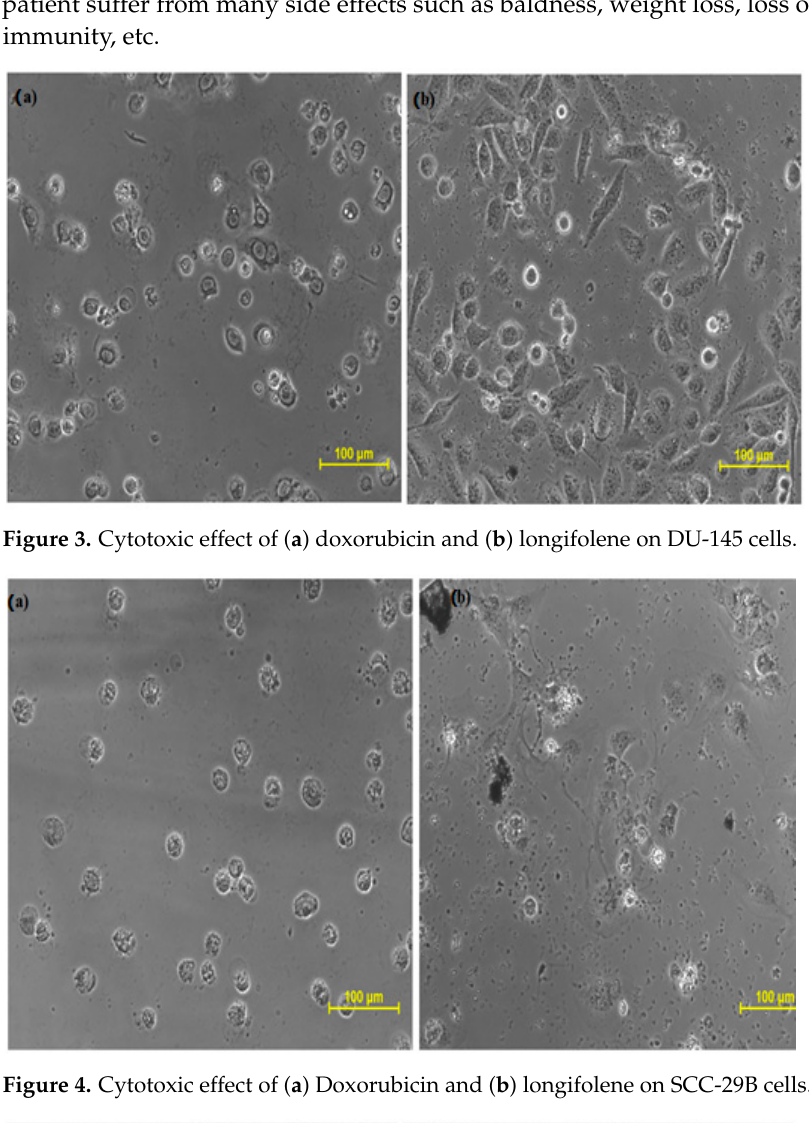
Figure 3. Cytotoxic effect of ( a ) doxorubicin and ( b ) longifolene on DU-145 cells. Table 2. MTT assay of doxorubicin and longifolene on SCC-29B.